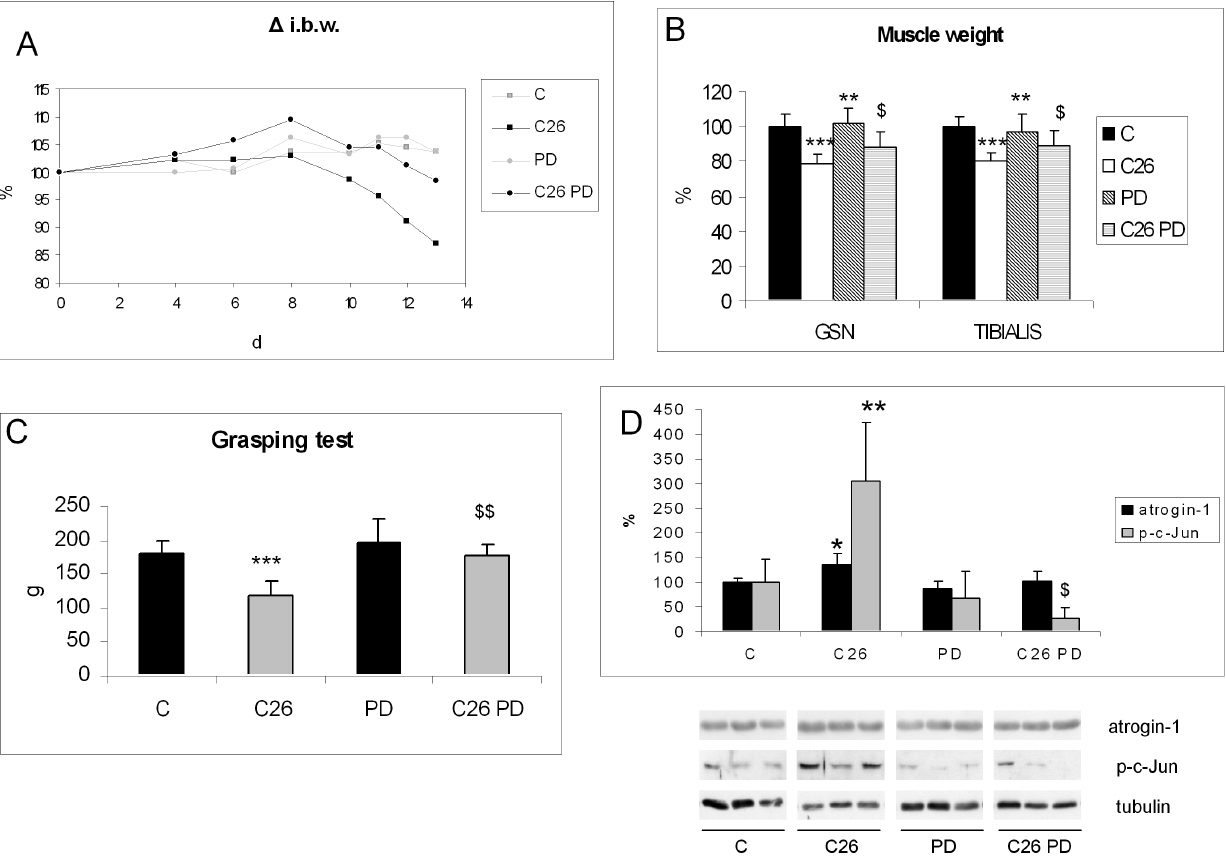
Figure 2. PD98059 counteracts the onset of cachexia in C26-bearing mice. (A) Body weight, expressed as percent changes respect to initial body weight (i.b.w., C=19.14 6 1.68 g; C26=19.14 6 0.69 g; PD=18.57 6 2.37 g; C26 PD=17.56 6 0.89 g), (B) muscle weight, (C) voluntary strength (grasping test), (D) atrogin-1 and p-c-Jun protein expression in the GSN of controls (n=6) and C26 hosts (n=8) either untreated or administered PD (1 mg/kg; see Materials and methods). Densitometric quantifications were normalized according to tubulin levels. Data (means 6 SD) expressed as percentages of controls. Significance of the differences: *p , 0.05 vs C; **p , 0.01 vs C; ***p , 0.001 vs C; $ p , 0.05 vs C26; $$ p , 0.01 vs C26.